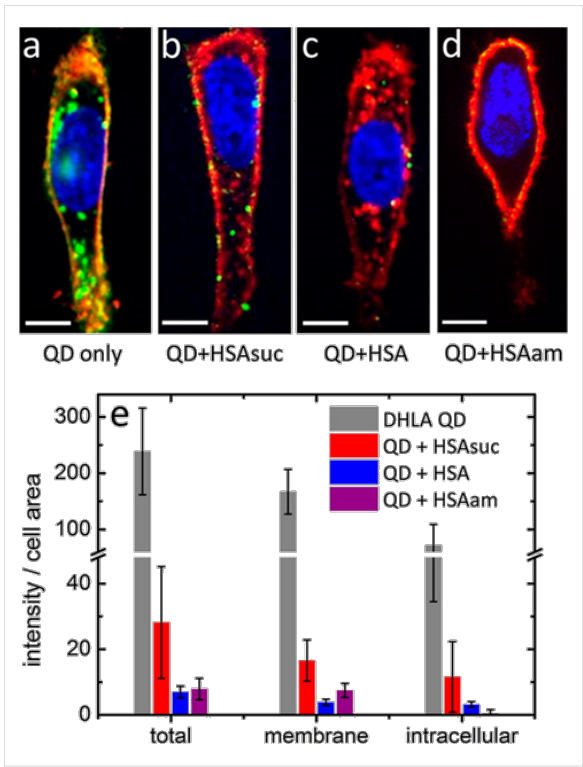
Figure 7: Fluorescence microscopy images (a–d) of the cellular uptake of DHLA-QDs by HeLa cells. Cells were incubated for 2 h with 10 nM QDs in PBS (a) without protein, (b) with 100 μ M HSAsuc, (c) with 100 μ M native HSA and (d) with 100 μ M HSAam (red: cell membrane blue: nucleus, green: QDs). Scale bar: 10 μ m. (e) Quanti- fied evaluation of NP uptake after 2 h. Error bars represent standard deviations due to variations between individual cells. Reprinted with permission from [4]. Copyright 2014 American Chemical